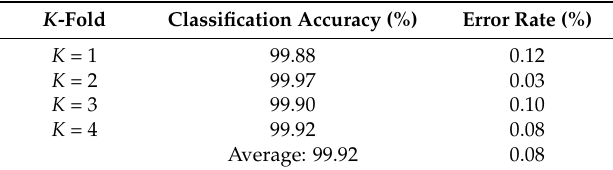
Table 5. Classification accuracy calculated by 4-fold cross-validation on the test dataset.